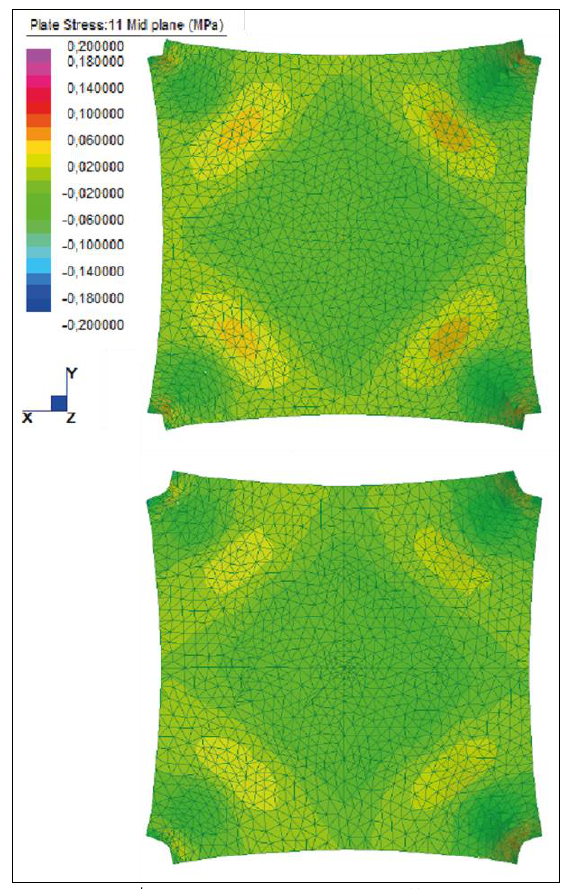
Figure 15. 1 st principal stress in the two different 3D mesh models: on the left applied to the surface deriving from algorithmic modelling and on the right to the surface commonly derived from the point